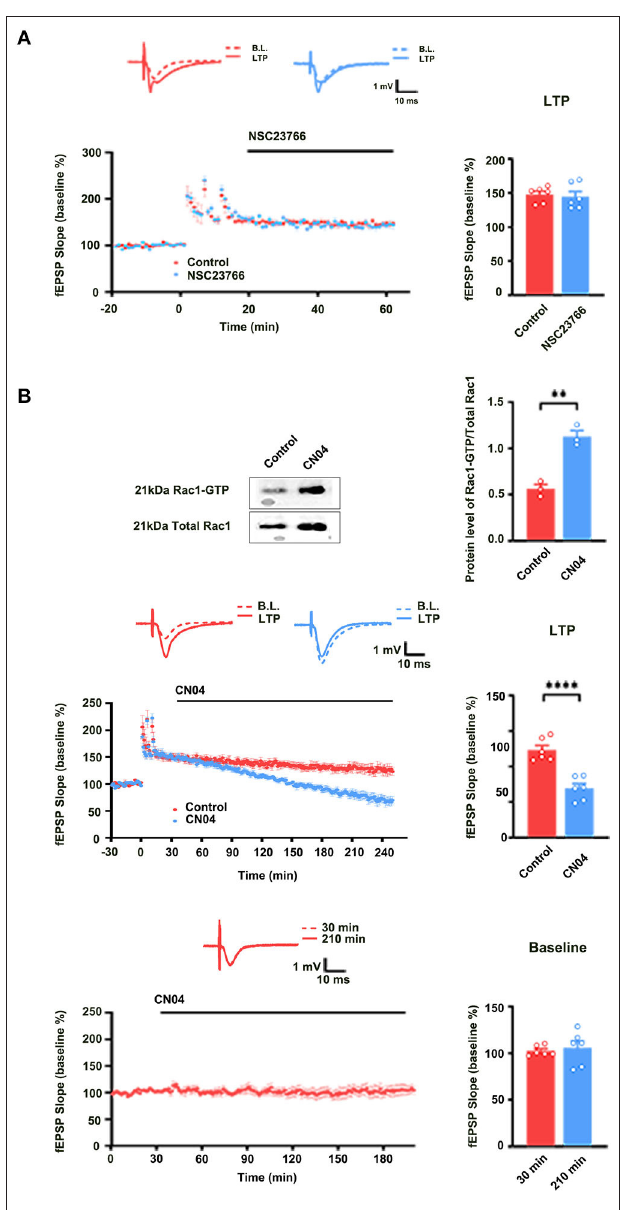
FIGURE 2 | The role of Rac1 in LTP maintenance. (A) Influence of Rac1 antagonist NSC23766 (100 µ M) on the LTP maintenance (Unpaired t- test, P > 0.05, n = 6 in each group). (B) Top: Influence of Rac1 agonist CN04 (424nM) on Rac1 activation (unpaired t- test, ** P < 0.01, n = 3 in each group). Top right: Average fEPSP slope during the last 15min of the LTP recording. Middle: Influence of Rac1 agonist CN04 (424nM) on the LTP maintenance (unpaired t- test, **** P < 0.0001, n = 6 in each group). Middle right: Average fEPSP slope during the last 15min of the LTP recording. Bottom: Influence of Rac1 agonist CN04 (424nM) on the fEPSP baseline (unpaired t- test, P > 0.05, n = 6 in each group). All data are shown as mean ± SEM.